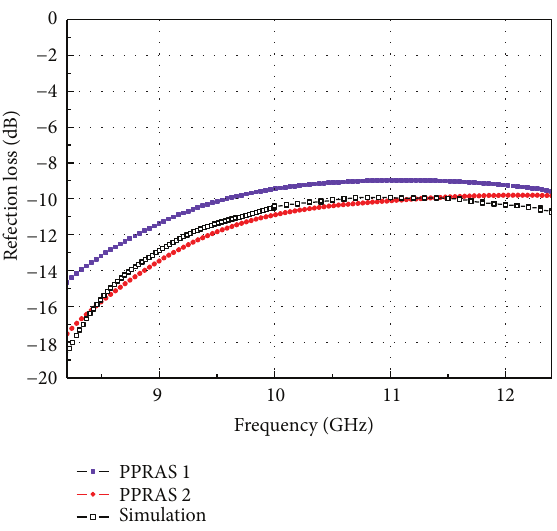
Figure 7: Reflection loss of the PPRA in